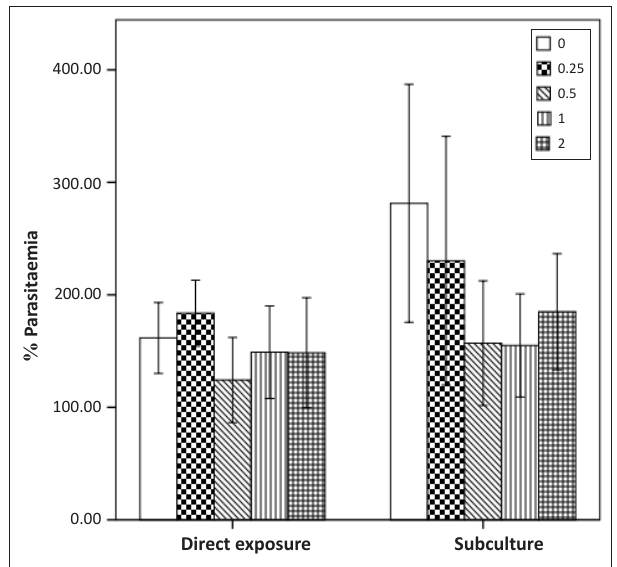
FIGURE 1: Percentage parasitaemia following direct exposure of Babesia caballi cultures to turpentine and percentage parasitaemia following subculture in the absence of